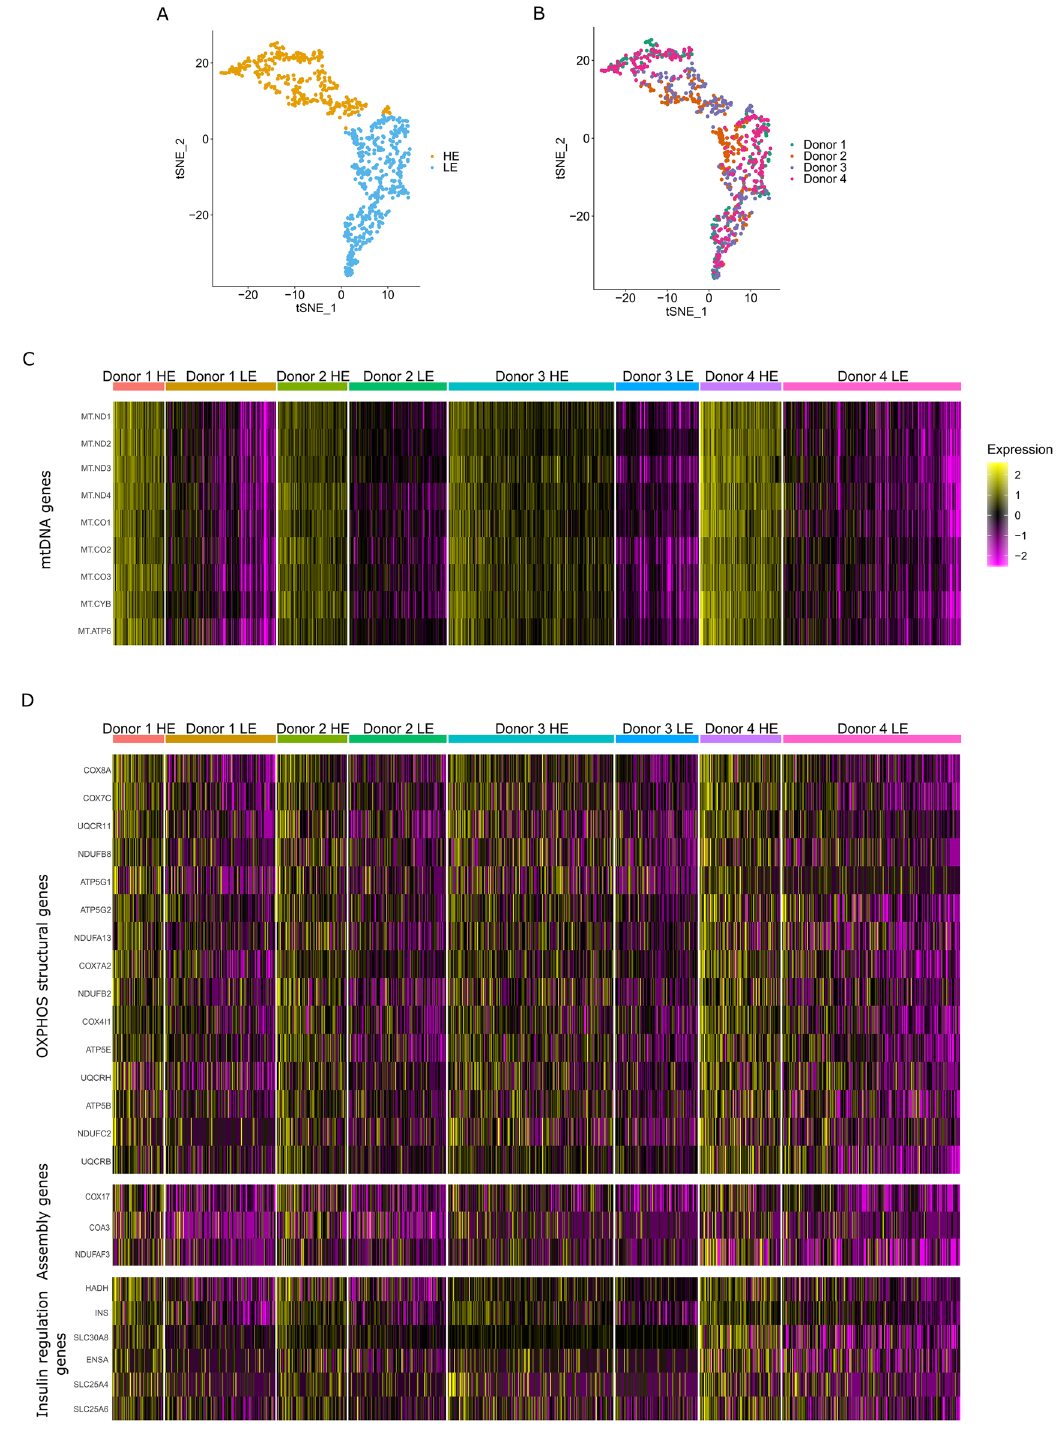
Figure 2. Human mtDNA gene expression analysis revealed two distinct beta cell clusters with either high or low mtDNA gene expression (designated HE and LE, respectively). ( A , B ) tSNE distribution of beta cells from the four human donors (Dataset I) showing two subgroups of beta cells with high and low mtDNA gene expression. ( A ) Subgroups of cells with either high (HE) or low (LE) mtDNA gene expression (yellow and blue dots, respectively); ( B ) cells are divided into HE and LE according to mtDNA gene expression, regardless of donor identity (donor’s cells are colour coded as indicated). ( C , D ) Heatmap showing the significant differentially expressed genes per beta cell cluster, per individual (after FDR correction). ( C ) mtDNA-encoded transcripts, ( D ) Upper panel—OXPHOS structural genes; Middle panel—OXPHOS assembly genes; lower panel—genes involved in insulin regulation. Colour codes: purple—low expression, yellow—high